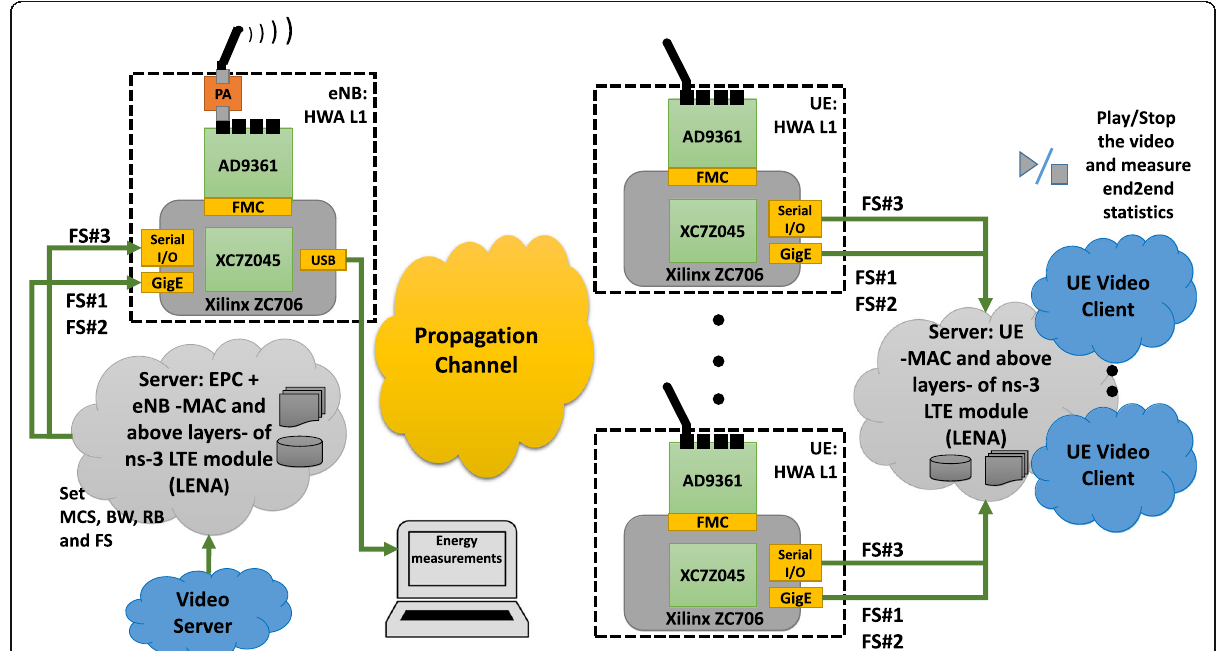
Fig. 6 Testbed where the FSs of Fig. 5 can be applied using reconfiguration of HWA/SW